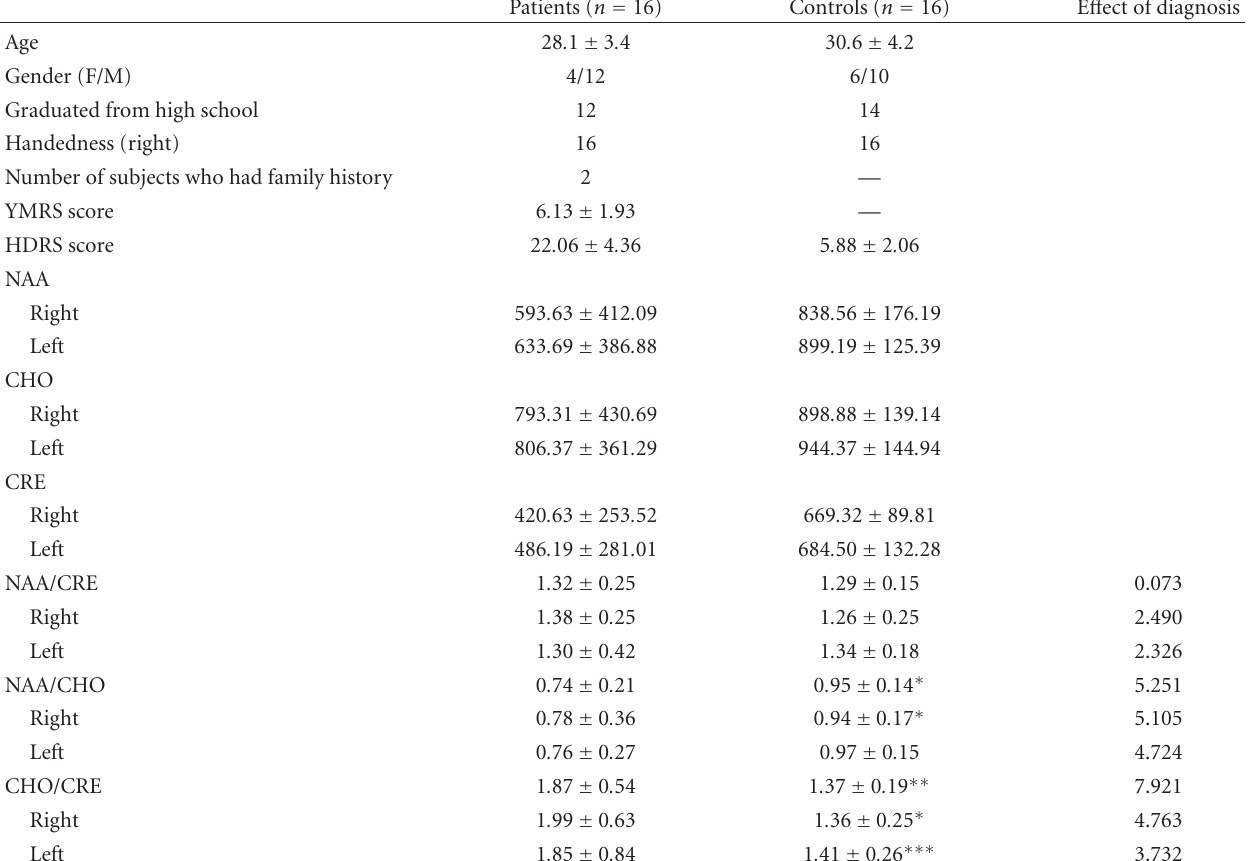
Table 1: Clinical and demographic information for healthy subjects and patients with bipolar